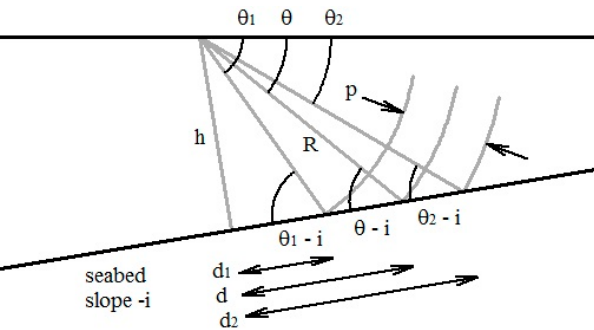
Figure 1. Acoustic rays from the sonar to the center of the sonar pulse on the seabed in the direction of propagation, and to the leading and trailing edges of the pulse on the seabed for R > ( h + p /2 ) . Along-trace side view. The direction of motion of the sonar vehicle is into the page.